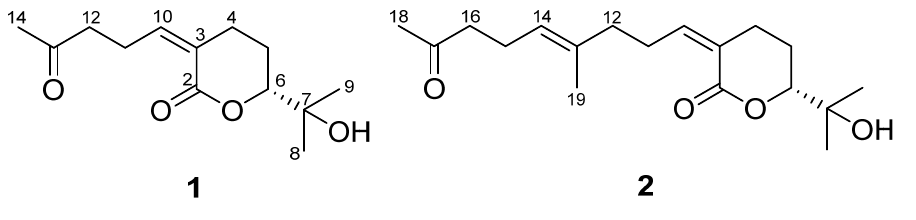
Figure 1. Structures of compounds 1 and 2 .